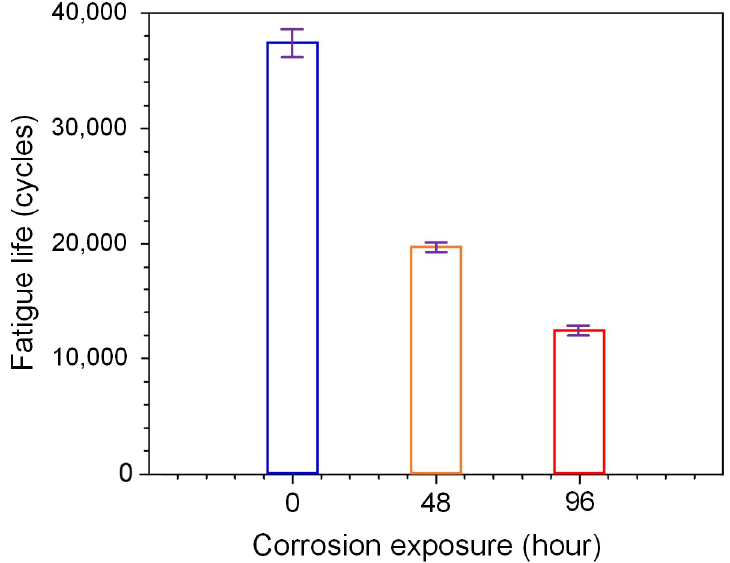
Figure 4. Measured effect of corrosion time on fatigue life at a stress level of σ max = 330 MPa, R = 0.2.